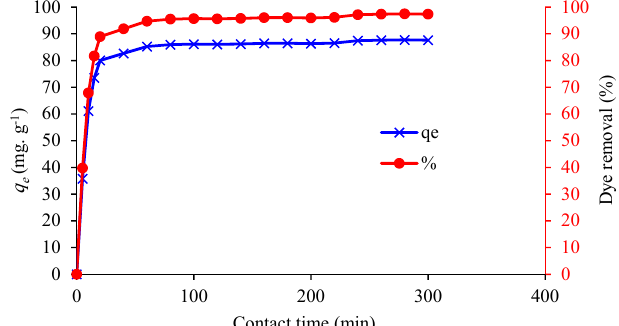
Fig. 11: Effect of contact time on MB adsorption by Fe